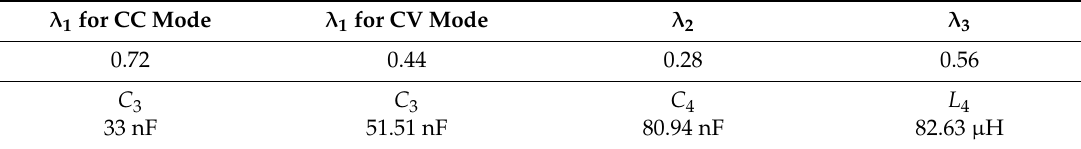
Table 3. Theoretically calculated parameter values of second